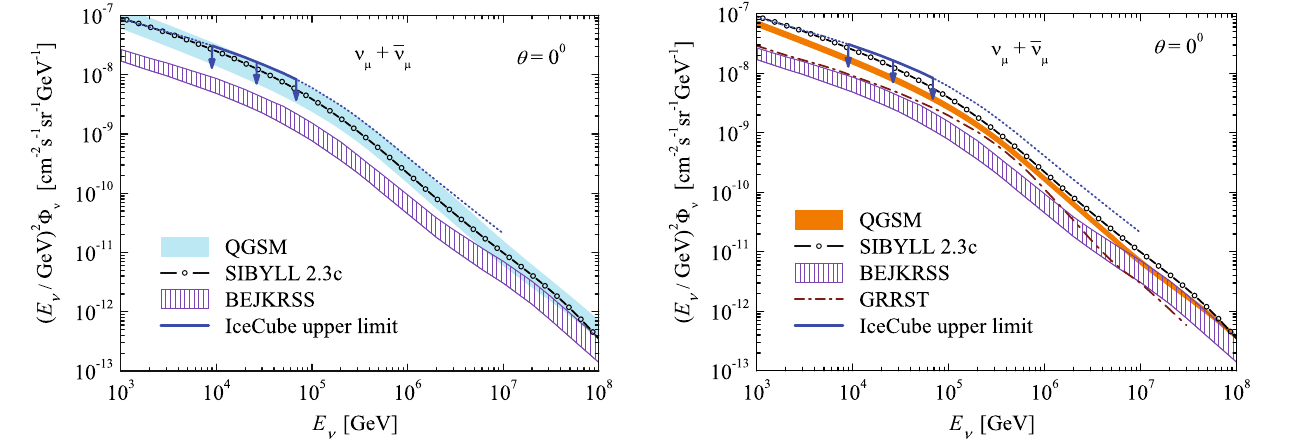
Fig. 17 Uncertainties of the prompt neutrino flux calculations. The blue band corresponding to QGSM calculations shows the effect of varying crucial parameter: the intercept α ψ ( 0 ) = 0 (upper bound of the band) and α ψ ( 0 ) = − 2 . 2 (lower bound). The hatched area presents the scale of uncertainties of the flux calculation with the NLO pQCD model BEJKRSS [24]. The SIBYLL 2.3c prediction [23] is compatible with QGSM (the line inside band). All calculations are performed for the H3a cosmic-ray spectrum. The solid line with arrows represents the IceCube limitation and dotted line labels its extrapolation [1]